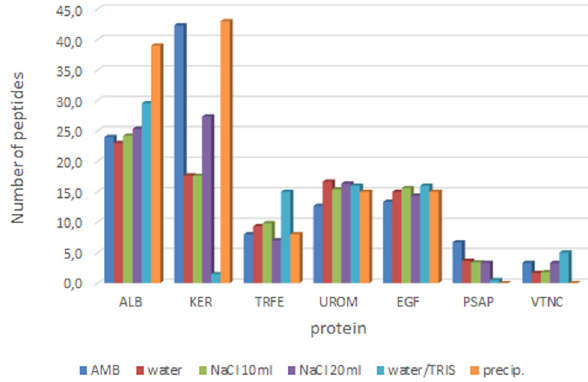
Figure 3: Number of peptides for the selected proteins identi fi ed by di ff erent extraction procedures. AMB – ultra fi ltration against AMB; water – ultra fi ltration against water; NaCl 10 mL – ultra fi